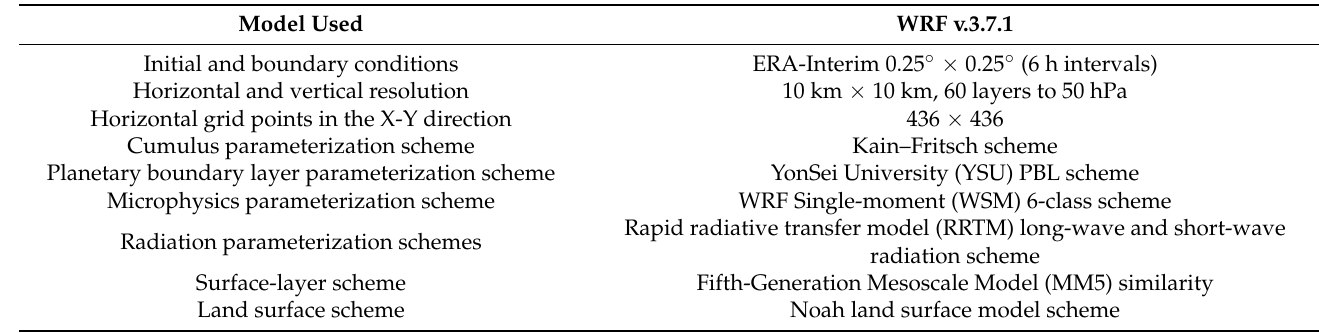
Table 1. Overview of the WRF model configuration for the present analyses of sea surface wind hindcasting around the Korean Peninsula during